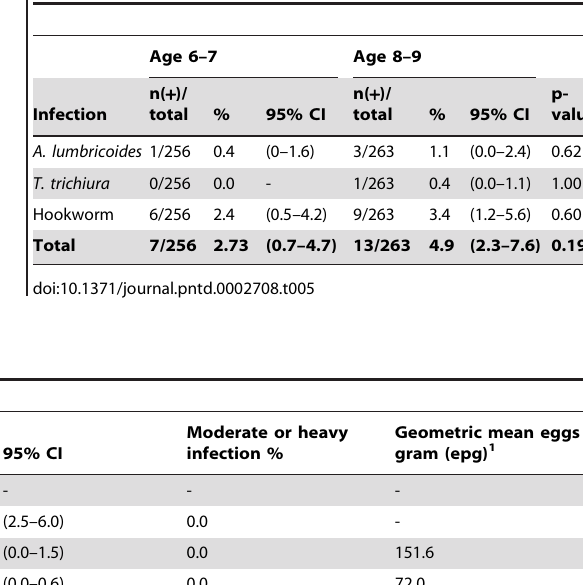
Table 5. Benin STH infection by age